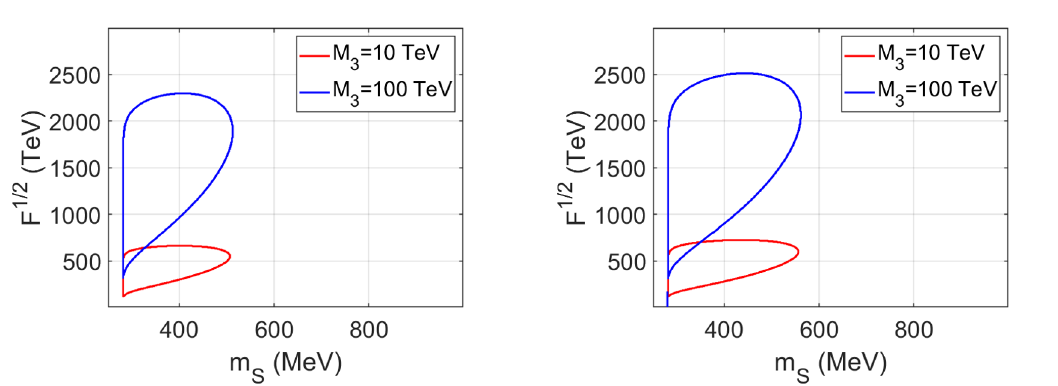
Figure 19 . Sensitivity regions of FASER-II to the model parameters, where sgoldstinos are pro- duced directly and then decay inside the detector volume into mesons. When only charged mesons are used as a signature, the regions are presented on left panel. The right panel shows the re- gion, when both charged and neutral mesons are exploited as sgoldstino signatures. Only pions are √ √ kinematically viable. In the regions where F < M 3 we set M 3 = F .